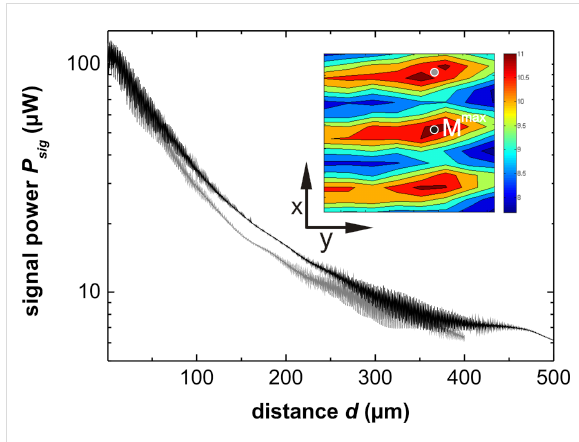
Figure 8: Interferometer signal power P sig of the main maximum (black) and a side maximum (gray) measured for cantilever 1 as a function of d . The inset shows the pattern in the xy -plane around the main maximum for the fiber–cantilever distance d = 330 μ m, with the positions of the distance-dependent measurements marked with black and gray circles, respectively.